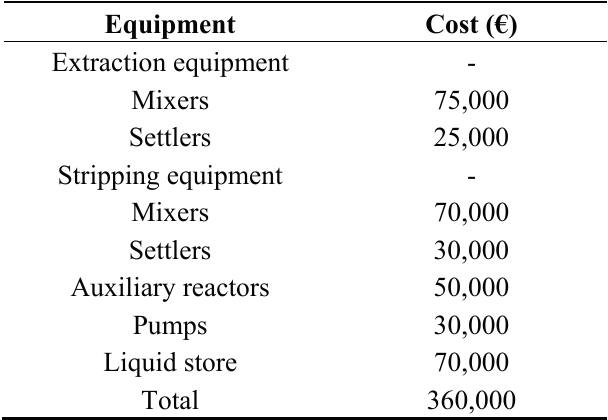
Table 5. Factors for global investment